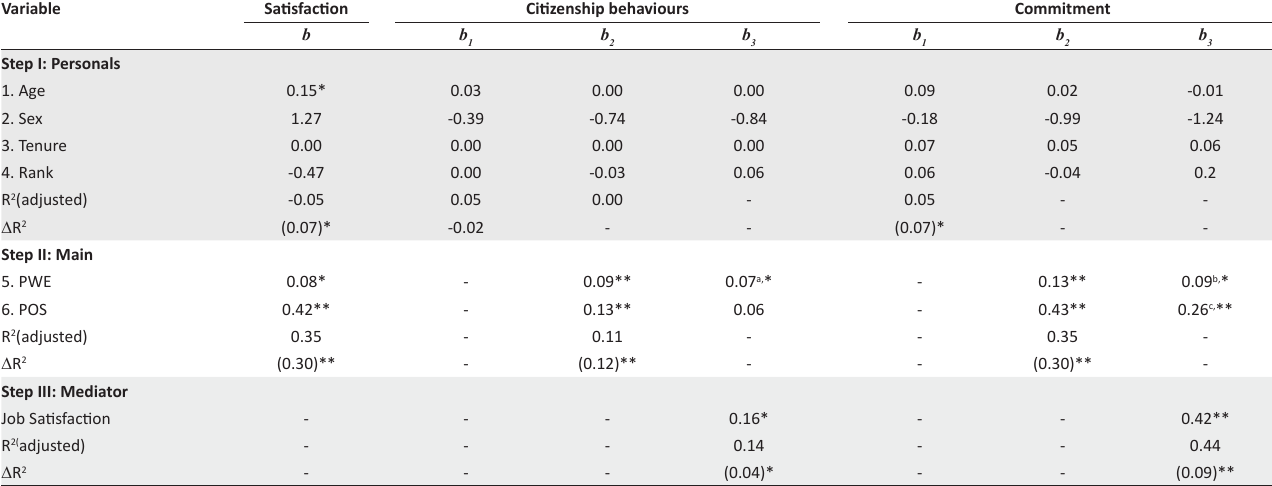
TABLE 2: Hierarchical regression results for predictors, mediator and outcomes.